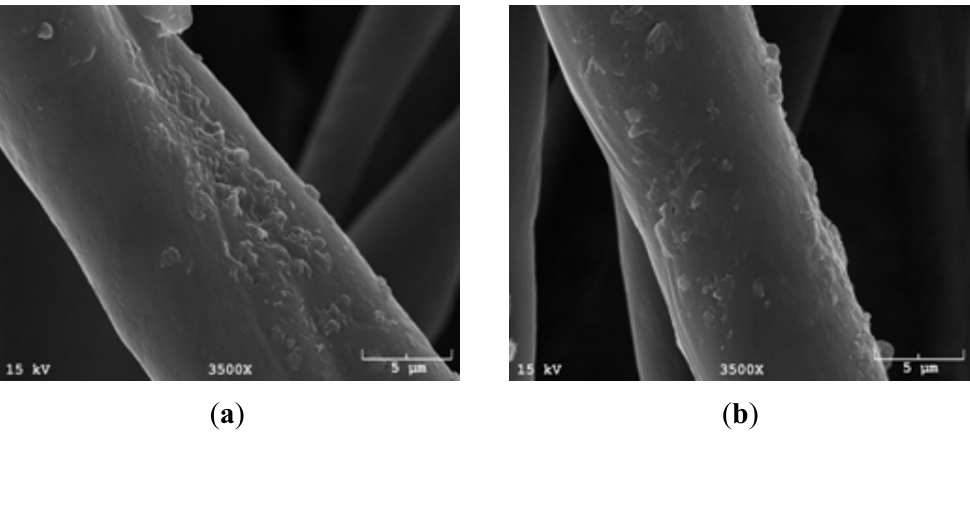
Figure 2. Interlock knit cotton fibers treated with PA1 (a,b) and